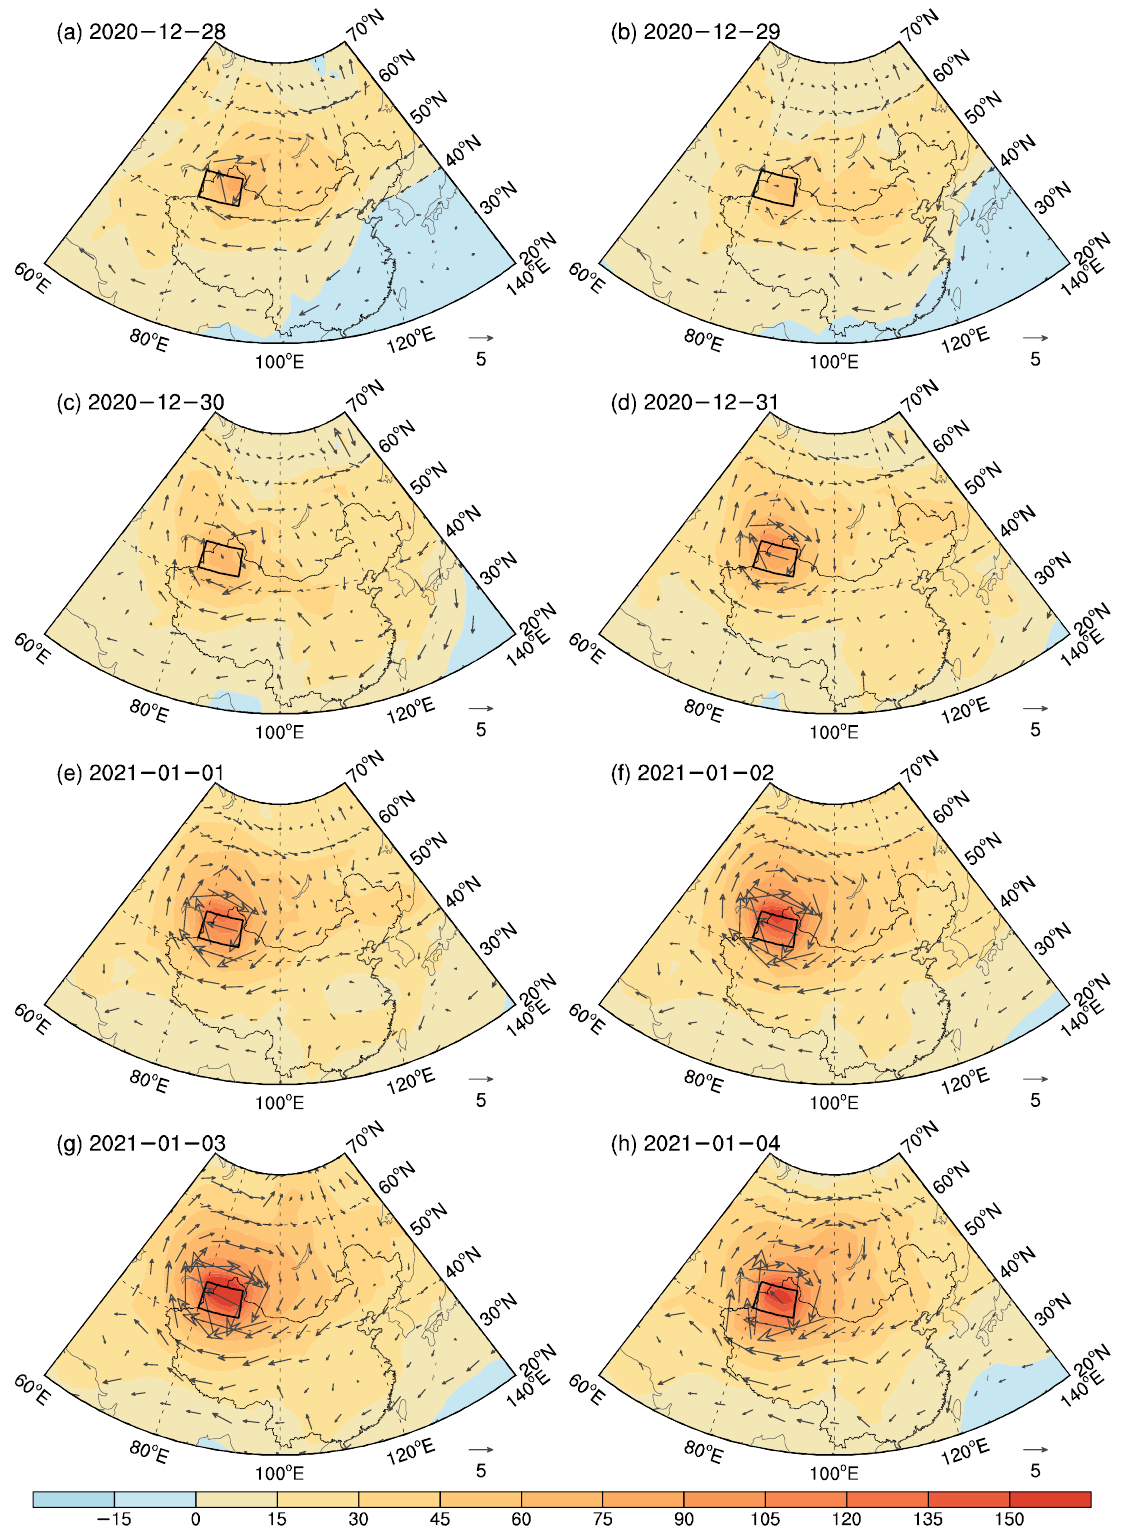
Figure 7. Daily 850 hPa geopotential height anomaly (shading, unit: gpm) and wind anomalies (arrows, units: m s − 1 ) via the piecewise PV inversion on 850 hPa ( a – h ) from 28 December 2020 to 4 January 2021. The black box is the key region over (42°N – 47°N, 80°E – 90°E).